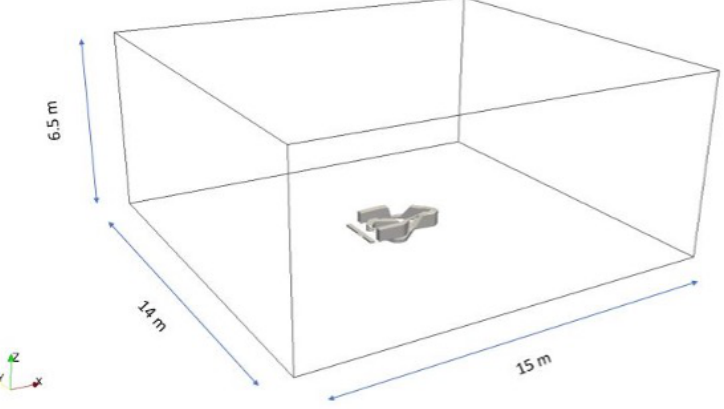
Figure 9. Geometry of the overall domain and related dimensions.